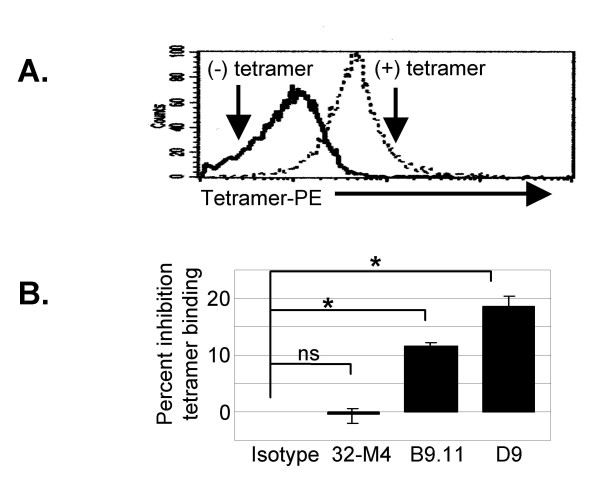
CD8α on human peripheral blood monocytes mediates MHC class I binding. A, Dark histogram is background fluorescence of CD14hi monocytes, light histogram represents binding of PE-labeled tetramers. B, Bar graph is pooled results of gated CD14hi monocytes from three different donors in separate experiments. Inhibition of tetramer binding is expressed as percent decrease in mean fluorescence intensity of tetramer binding due to pretreatment with anti-CD8α mAb compared to isotype mAb (* p < 0.05, non-paired t-test).